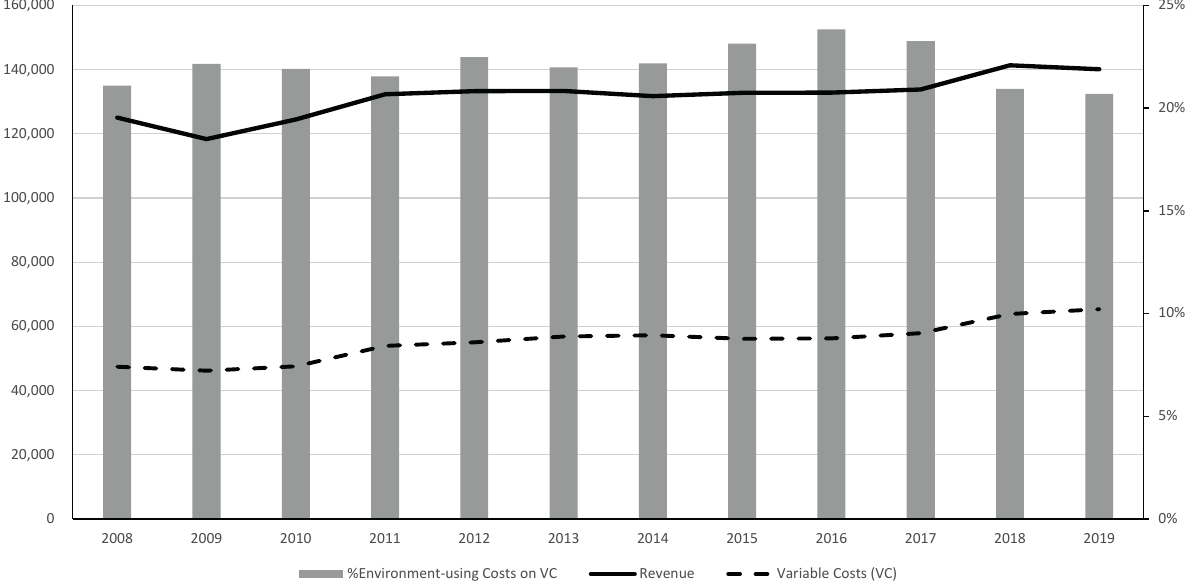
Figure 3. Average revenue, variable costs and environment-using costs (fertilizers, pesticides, energy, water) (€) over the 2008-2019 period within the Italian FADN balanced sample.